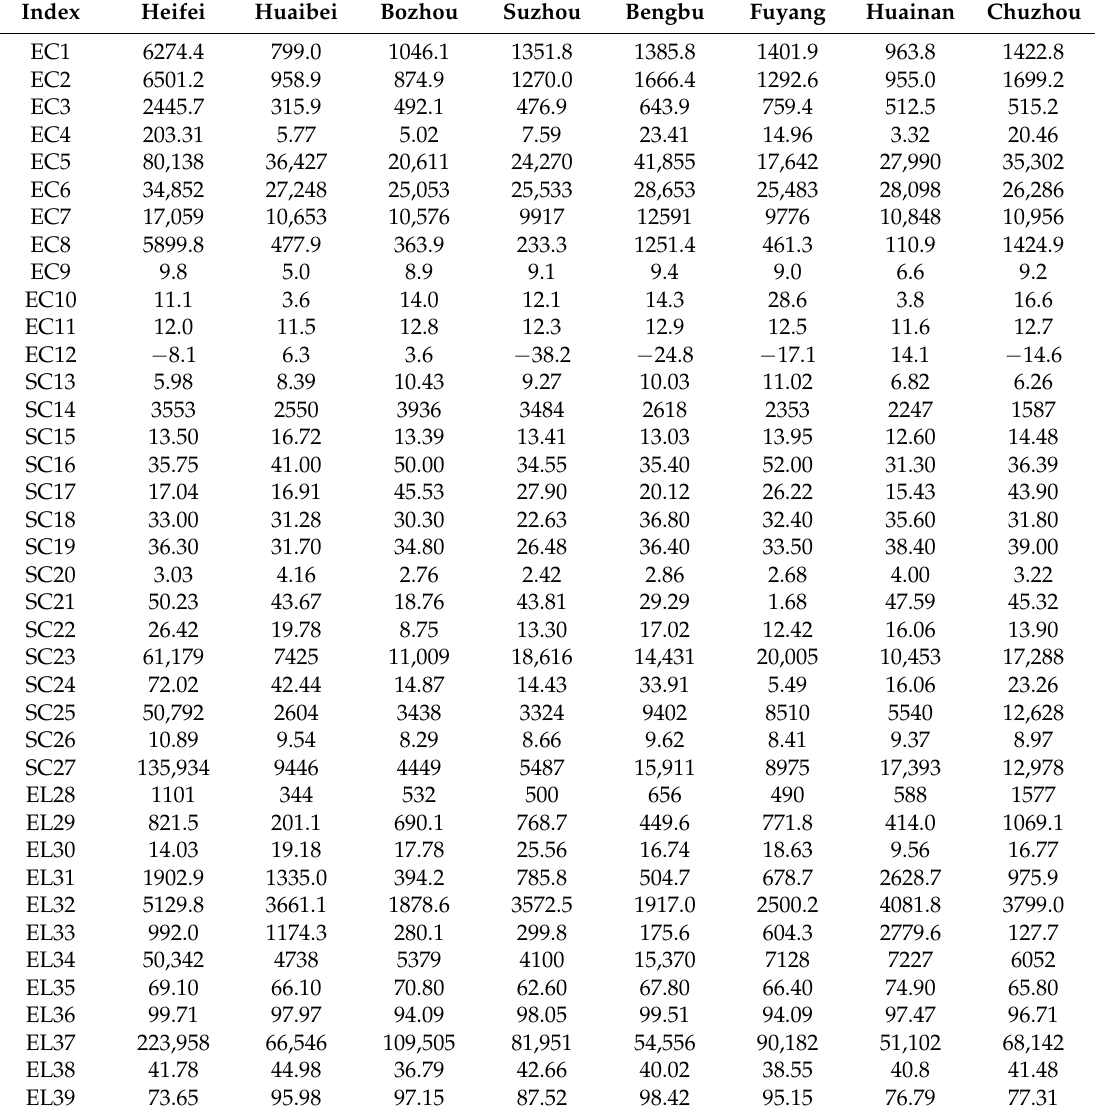
Table 2. Evaluation index data of eight cities of Anhui province in the north of Huaihe